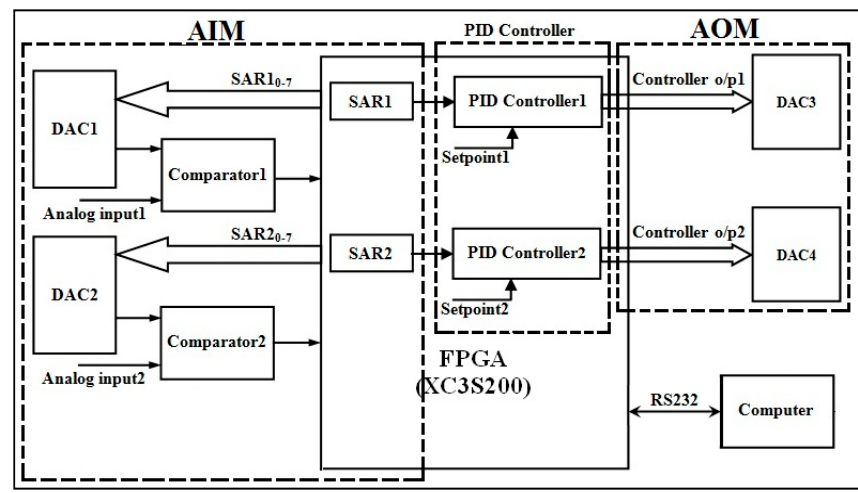
Figure 6. Closed-loop control system for two analog signals.